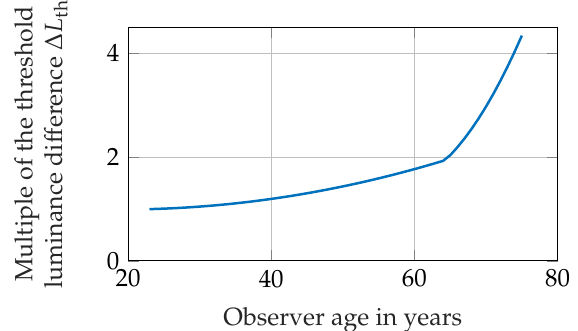
Figure 2. Age influence on the threshold luminance difference ∆ L th according to Blackwell and Blackwell [33]; the observer’s age has a significant influence on the required threshold luminance difference ∆ L th ; especially from an age of 64 years, the age influence increases significantly [33]. Contrast polarity also affects the threshold luminance difference required for object detection [15,18,36]. Studies by Aulhorn [15] and Damasky [18] demonstrate that the threshold luminance difference for positive and negative contrast is of the same magnitude but lower for negative contrast than for positive